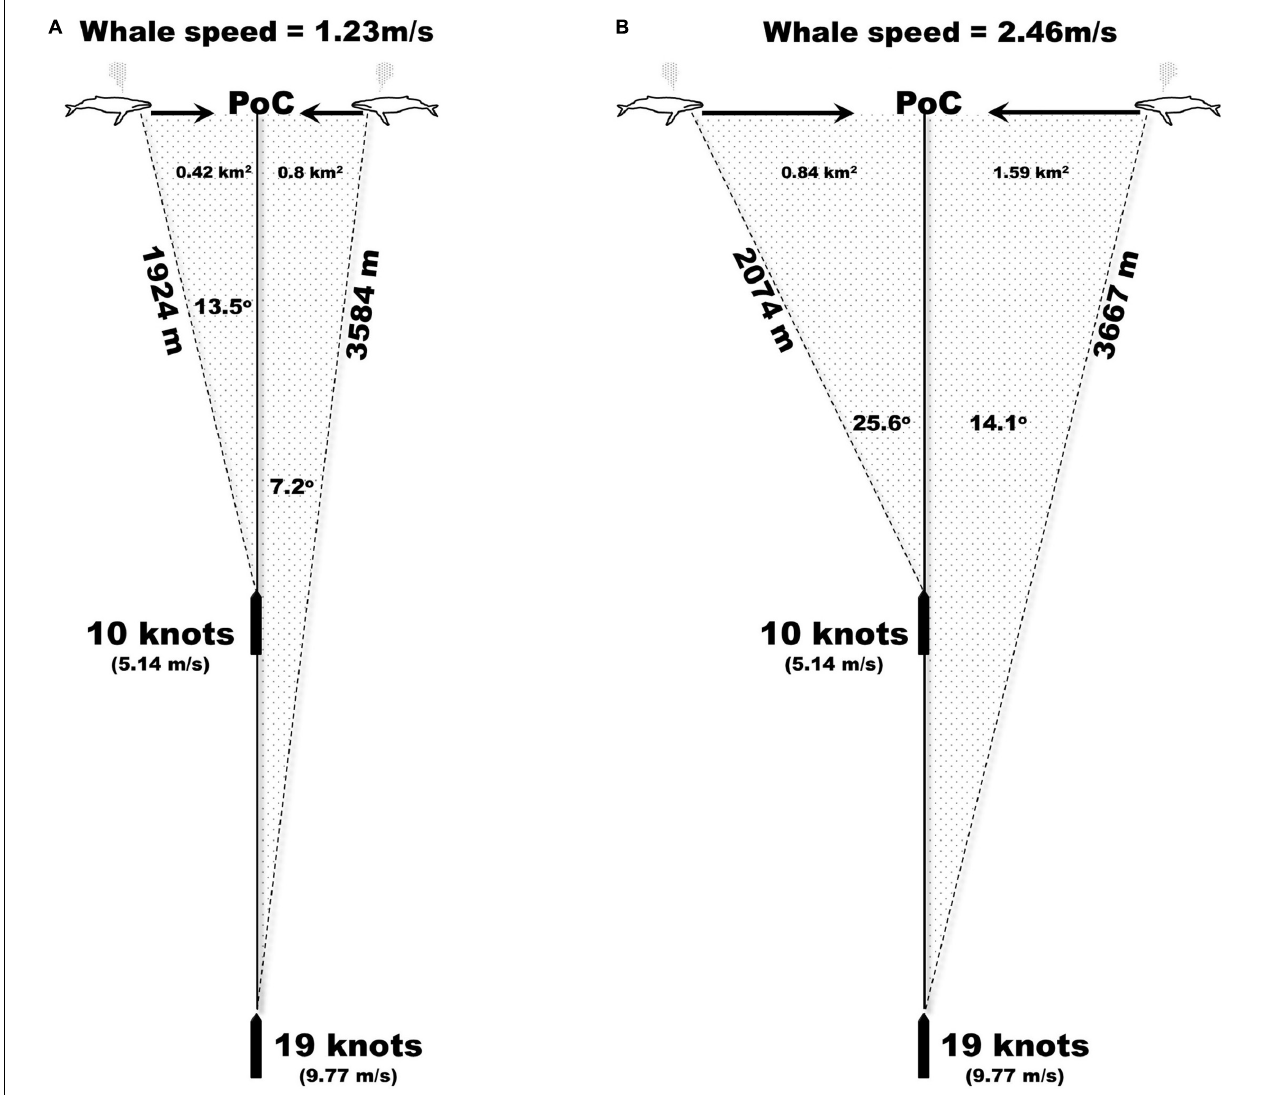
FIGURE 6 | Two scenarios encapsulating different ship transit and whale swimming speeds that define the ‘Cone of Concern’ (shaded area), i.e., the area searched by marine pilots to more efficiently detect surfacing whales that have the potential to be struck by the ship (at the bulbous bow). Figures depict the Cone for a 19-knot ship and 10-knot ship relative to an average swimming speed of a humpback whales (1.23 m/s; A ) and a fast swimming whale (2.46 m/s; B ) on a crossing pattern and on a collision course with the ship (PoC, Point of Collision; CPA = 0 m). Cones range from 14.4 ◦ (7.2 ◦ on either side of ship for fast ship and slow whale) to 51.2 ◦ (25.6 ◦ on either side of ship for a slow ship and fast whales). Distances are approximately to scale to a 284 m